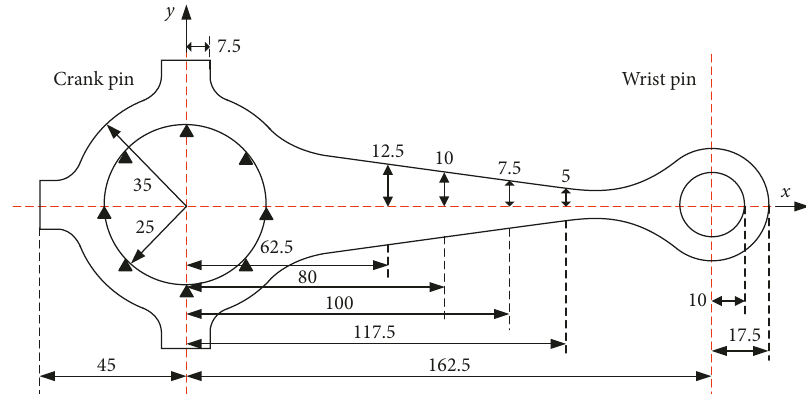
Figure 22: Geometric model and boundary conditions of automotive connecting rod.